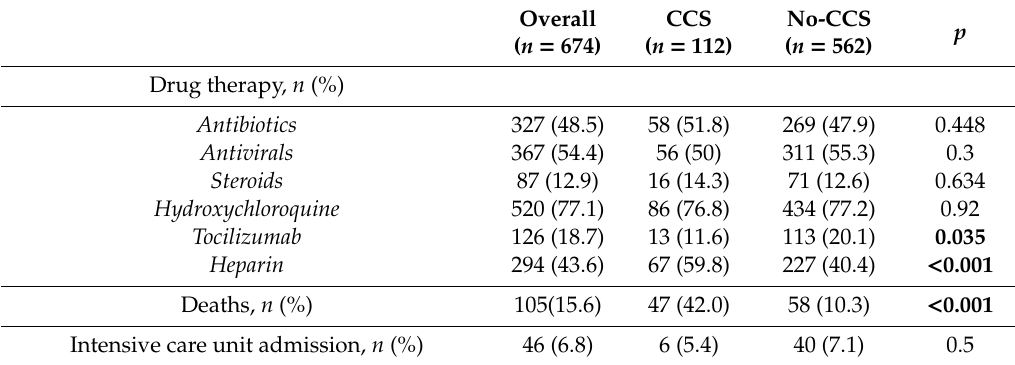
Table 3. Drug therapy and clinical outcomes during hospital